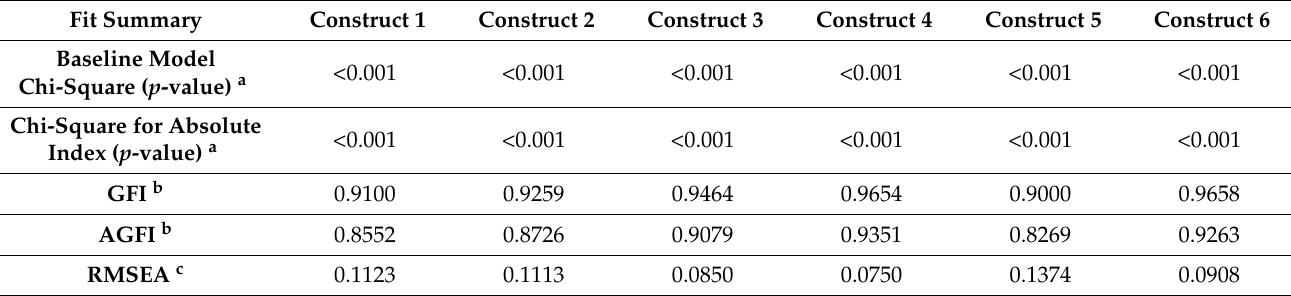
Table 4. Performance of different confirmatory factor analysis